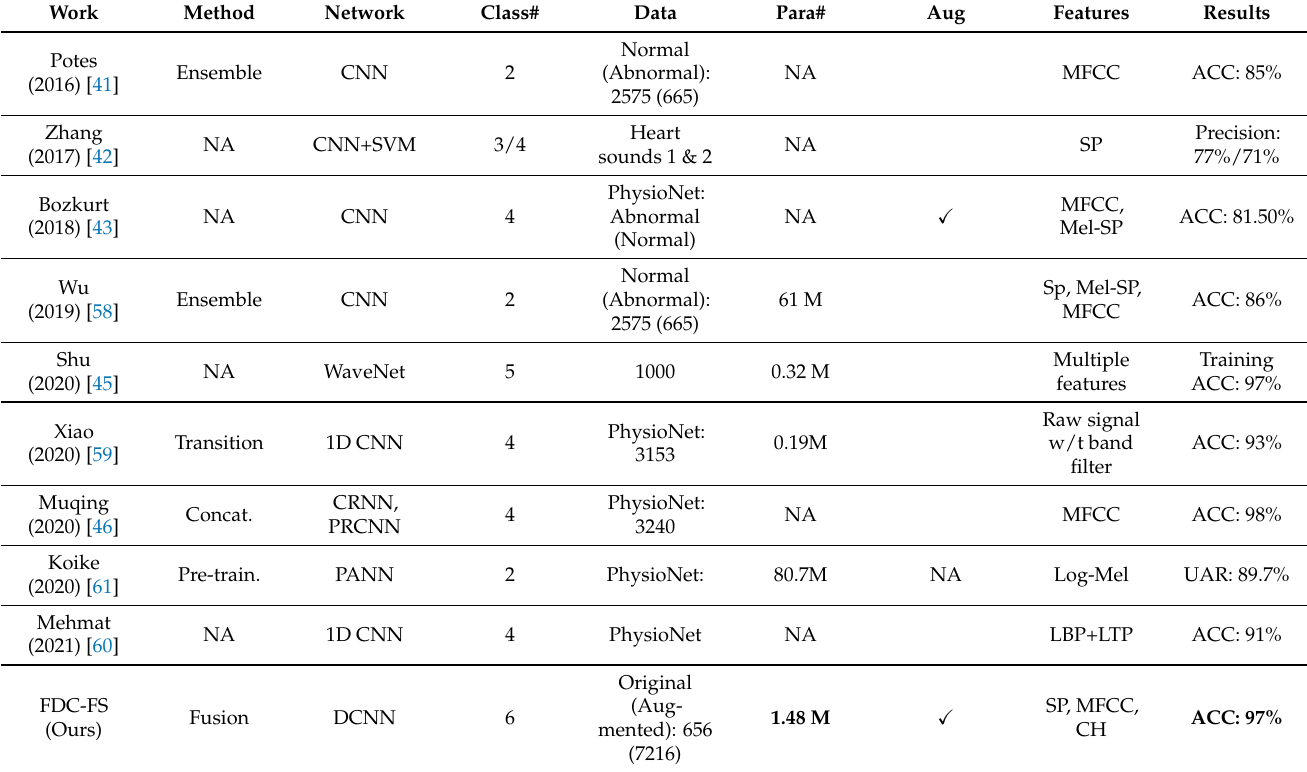
Table 13. State-of-the-art Heart Classification